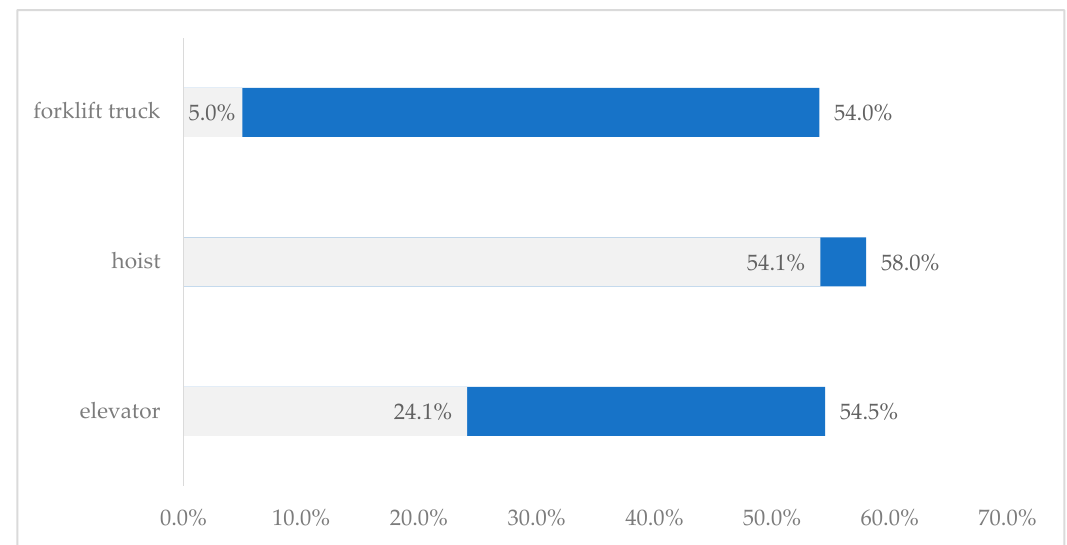
Figure 12. The range of energy-efficient rates of supercapacitor in different devices.